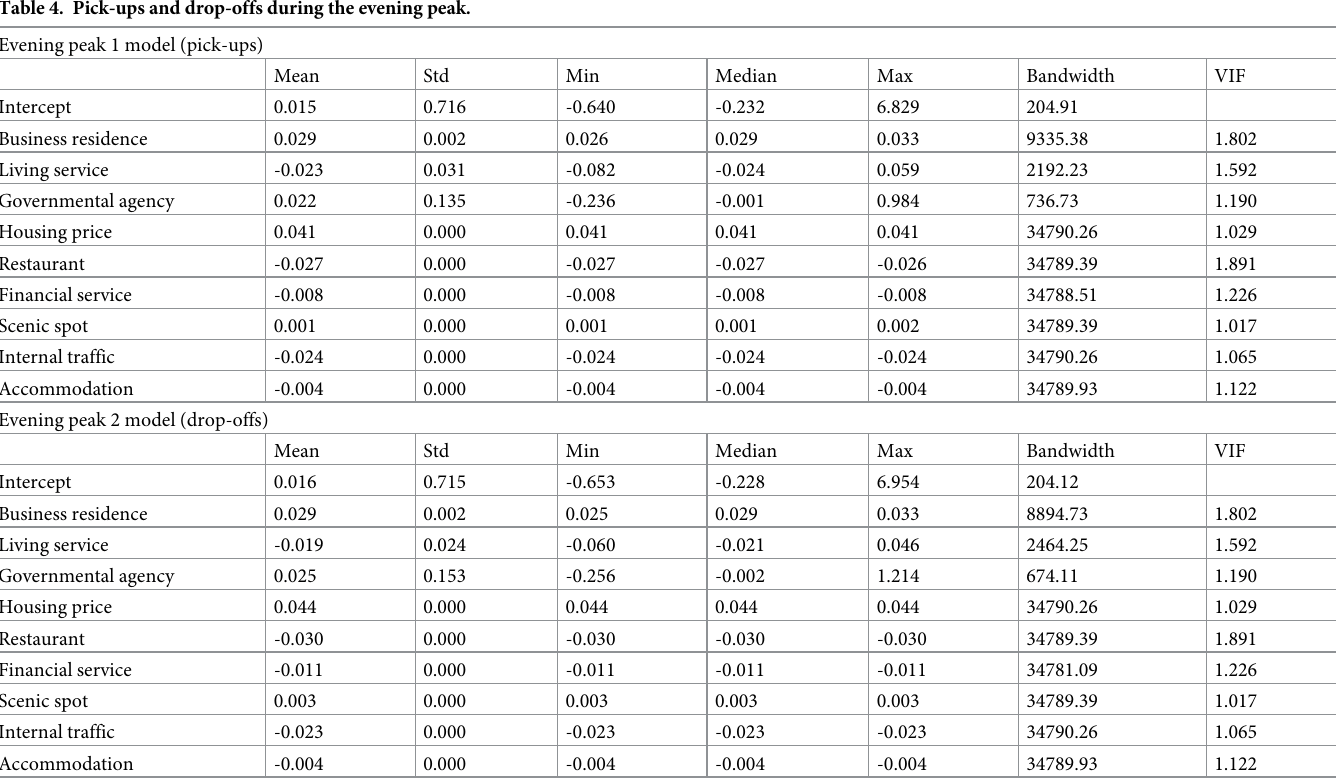
Table 4. Pick-ups and drop-offs during the evening peak.